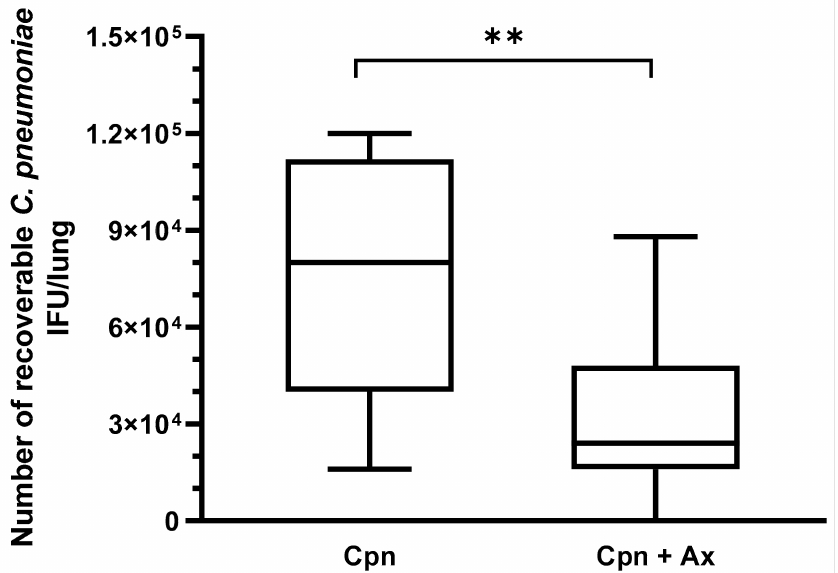
Figure 1. Recoverable C. pneumoniae IFU in infected mice ( n = 20) with and without Ax treatment. Ax-treated mice daily received 5-mg/kg Ax for 6 days. The supernatant of the lung homogenates was inoculated into a McCoy cell monolayer and cultured for 2 days, followed by fixation and staining, and the number of inclusions was determined via indirect immunofluorescence assay. (** p = 0.0049). Box = 25th percentile, median, and 75th percentiles; bars = min and max values. IFU, inclusion-forming unit; Cpn, C. pneumoniae -infected mice; Cpn + Ax, C. pneumoniae -infected mice treated with Ambroxol.